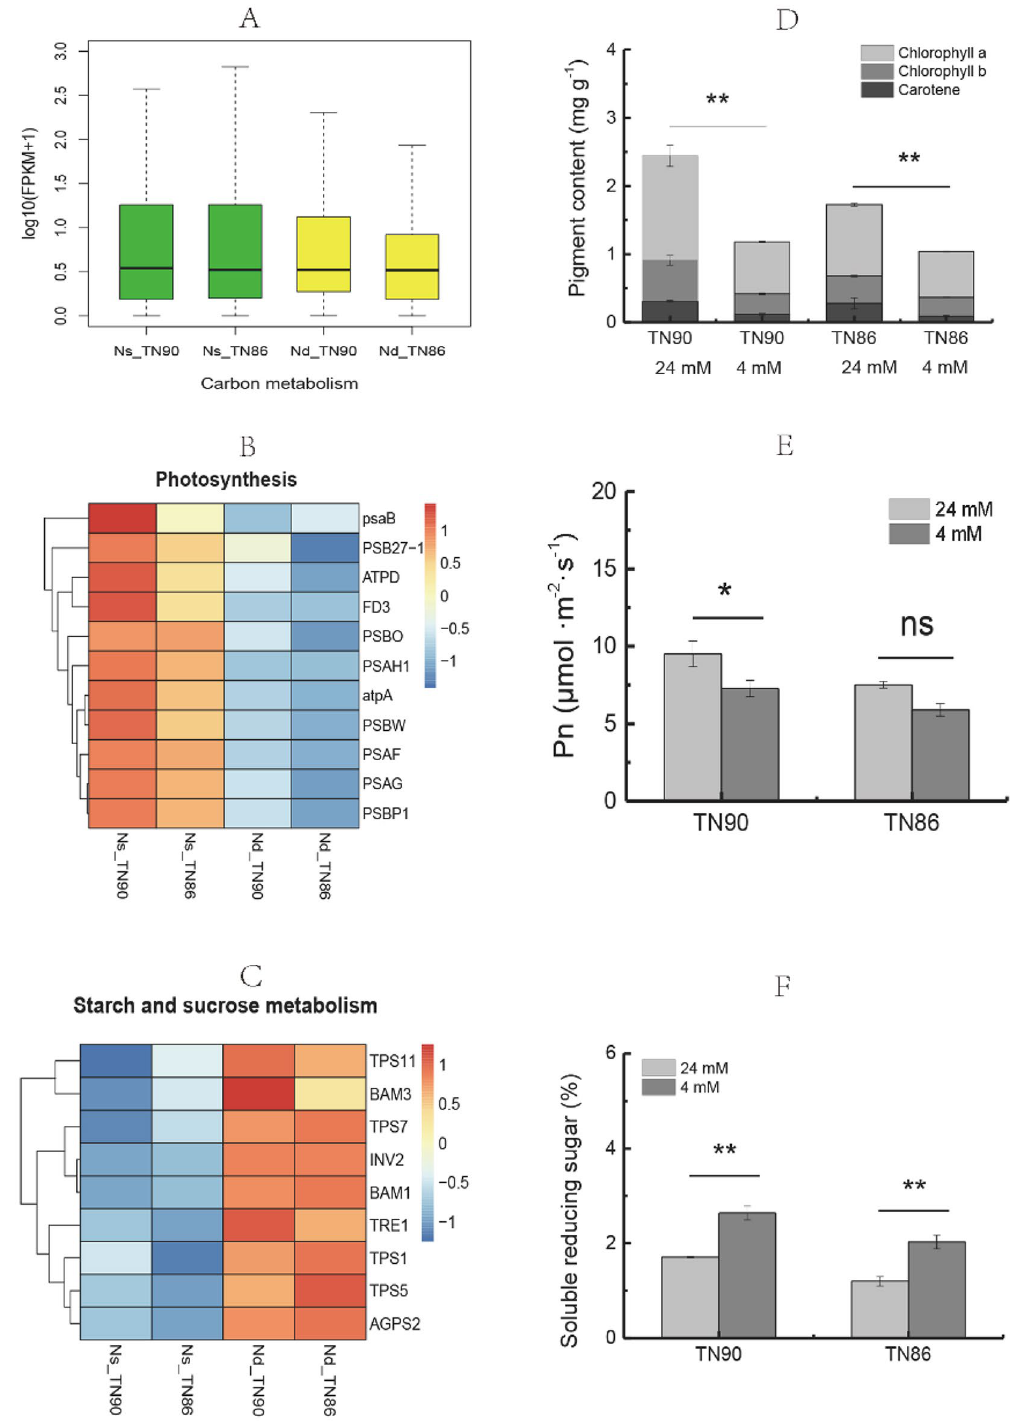
Figure 2. Carbon metabolism of burley tobacco under N-deficient conditions. ( A ) Primary transcripts associated with carbon metabolism; ( B ) expression pattern of genes related to photosynthesis; ( C ) expression pattern of genes related to starch and sucrose metabolism; ( D ) pigment levels; ( E ) photosynthesis rate (Pn); ( F ) soluble reducing sugar content. Symbol * and ** indicate a statistically significant differences between the nitrogen-deficient and nitrogen-sufficient conditions at p < 0.05 and p < 0.01, respectively. ns indicates no statistically significant difference between nitrogen-deficient and nitrogen-sufficient conditions at p < 0.05 or p < 0.01, respectively. Nd-TN90 TN90 cultivated under nitrogen-deficient conditions, Ns-TN90 TN90 cultivated under nitrogen-sufficient conditions, Nd-TN86 TN86 cultivated under nitrogen-deficient conditions, Ns-TN86 TN86 cultivated under nitrogen-sufficient conditions. Error bars of leaf biomass indicate standard error of the means (n =